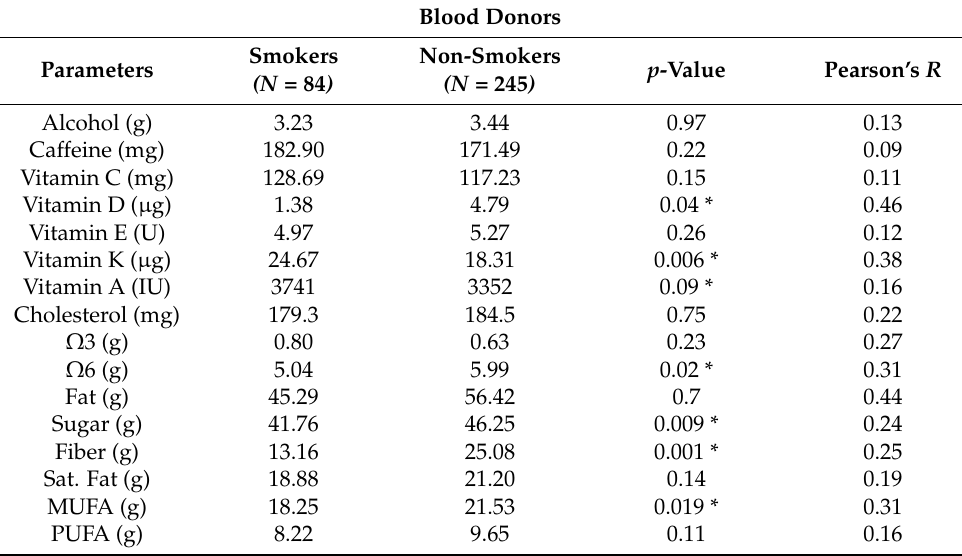
Table 4. Correlation of smokers and non-smokers with preferences in study population. Statistically significant differences are presented with